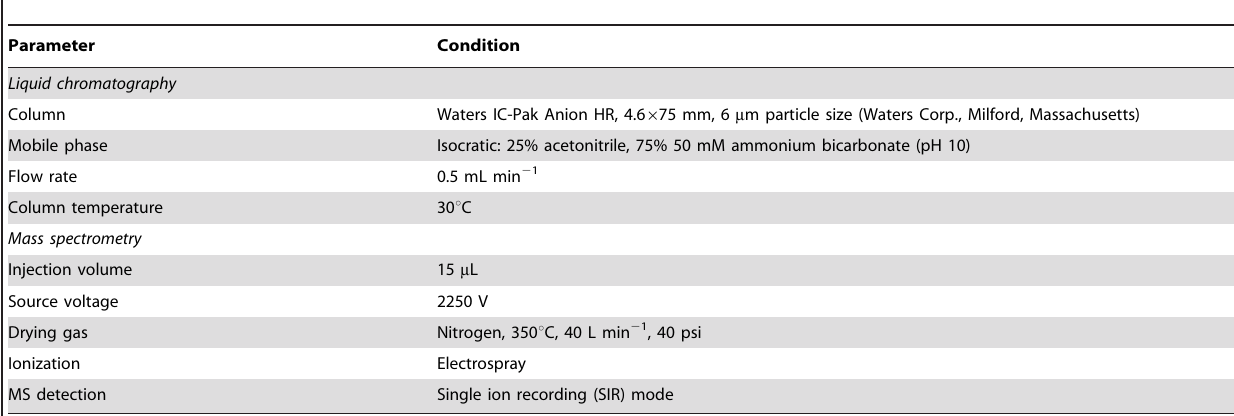
Table 1. Liquid chromatography and mass spectrometry conditions used for electrospray ionization mass spectrometer analysis of oxygen-18 labeled